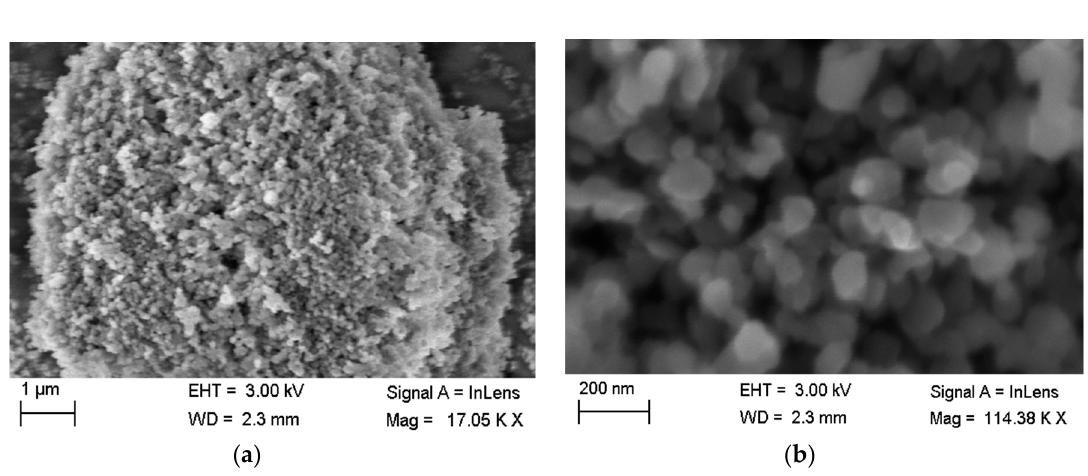
Figure 1. SEM images of resorcinol–formaldehyde (RF) xerogels synthesised at 20% solids content and a resorcinol/catalyst ratio of 600 at ( a ) 17.05 K X magnification and ( b ) 114.38 K X magnification. and a resorcinol / catalyst ratio of 600 at ( a ) 17.05 K X magnification and ( b ) 114.38 K X This SEM analysis was performed in collaboration with Farnaz Ghajeri at Angstrom Laboratory, Uppsala University.